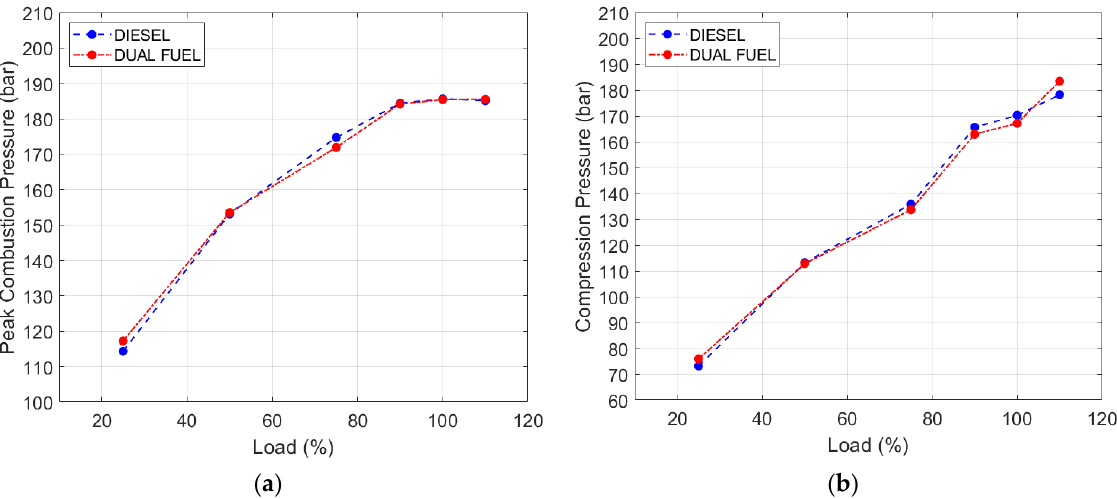
Figure 3. ( a ) Mean peak combustion pressure, diesel and DF modes; ( b ) Mean peak compression pressure, diesel and DF modes.